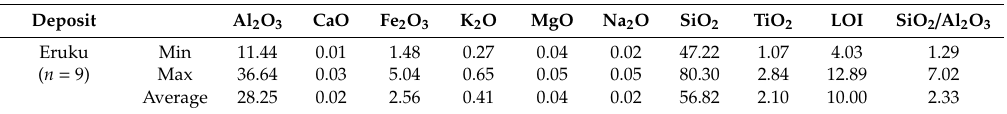
Table 5. Major oxide compositions (wt%) of the studied Cretaceous–Paleogene/Neogene kaolins compared with the world sedimentary kaolin deposits.